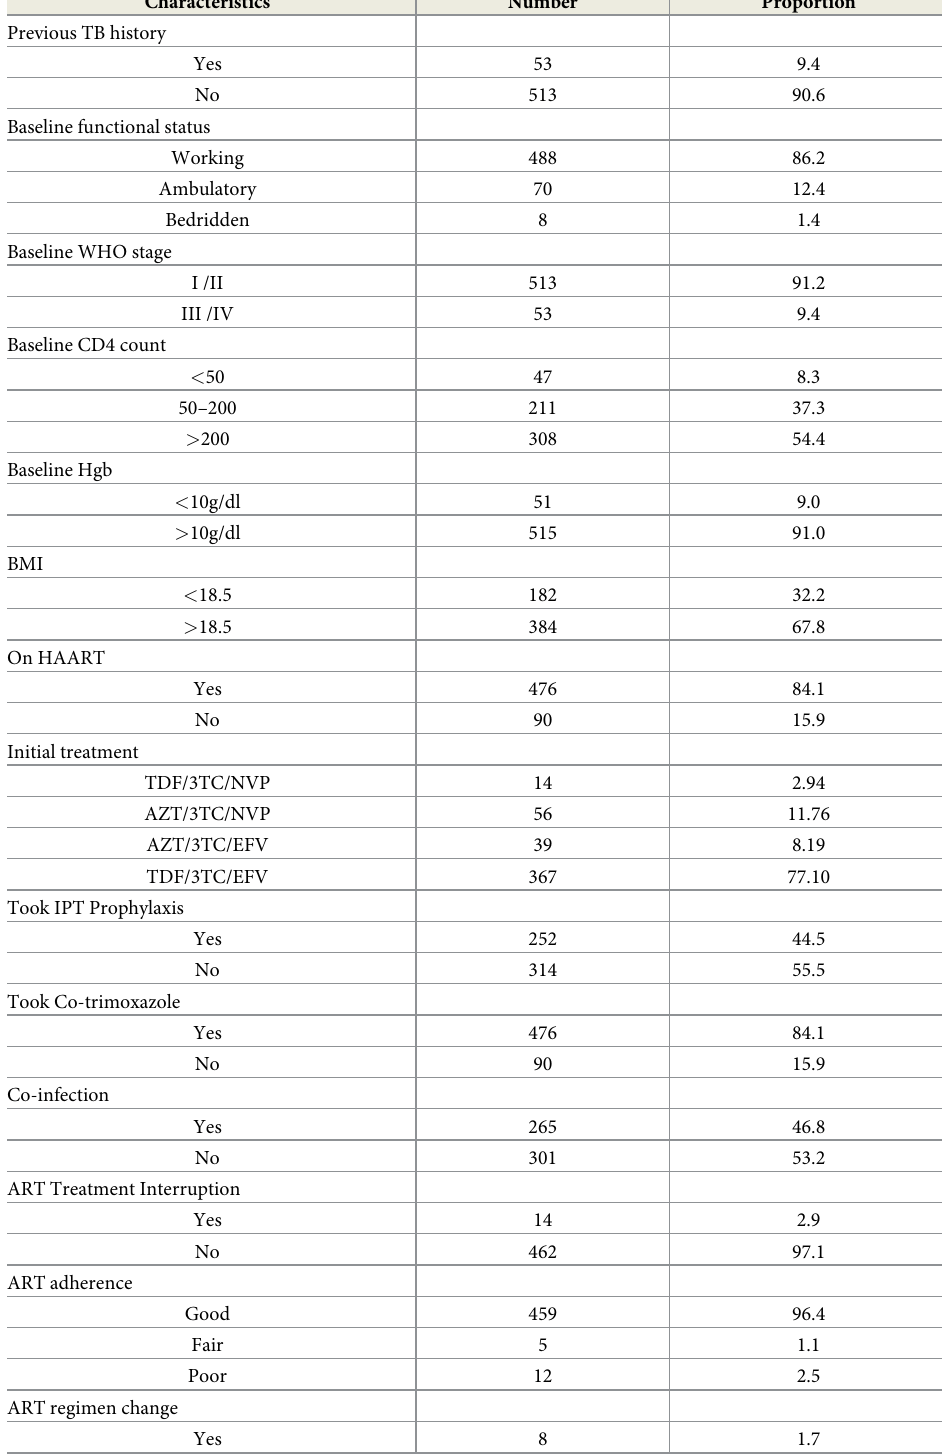
Table 2. Baseline and follow-up clinical characteristics among HIV positive patients in Addis Ababa, Ethiopia, from 01 January 2013 up to 31 December 2018 (n = 566).